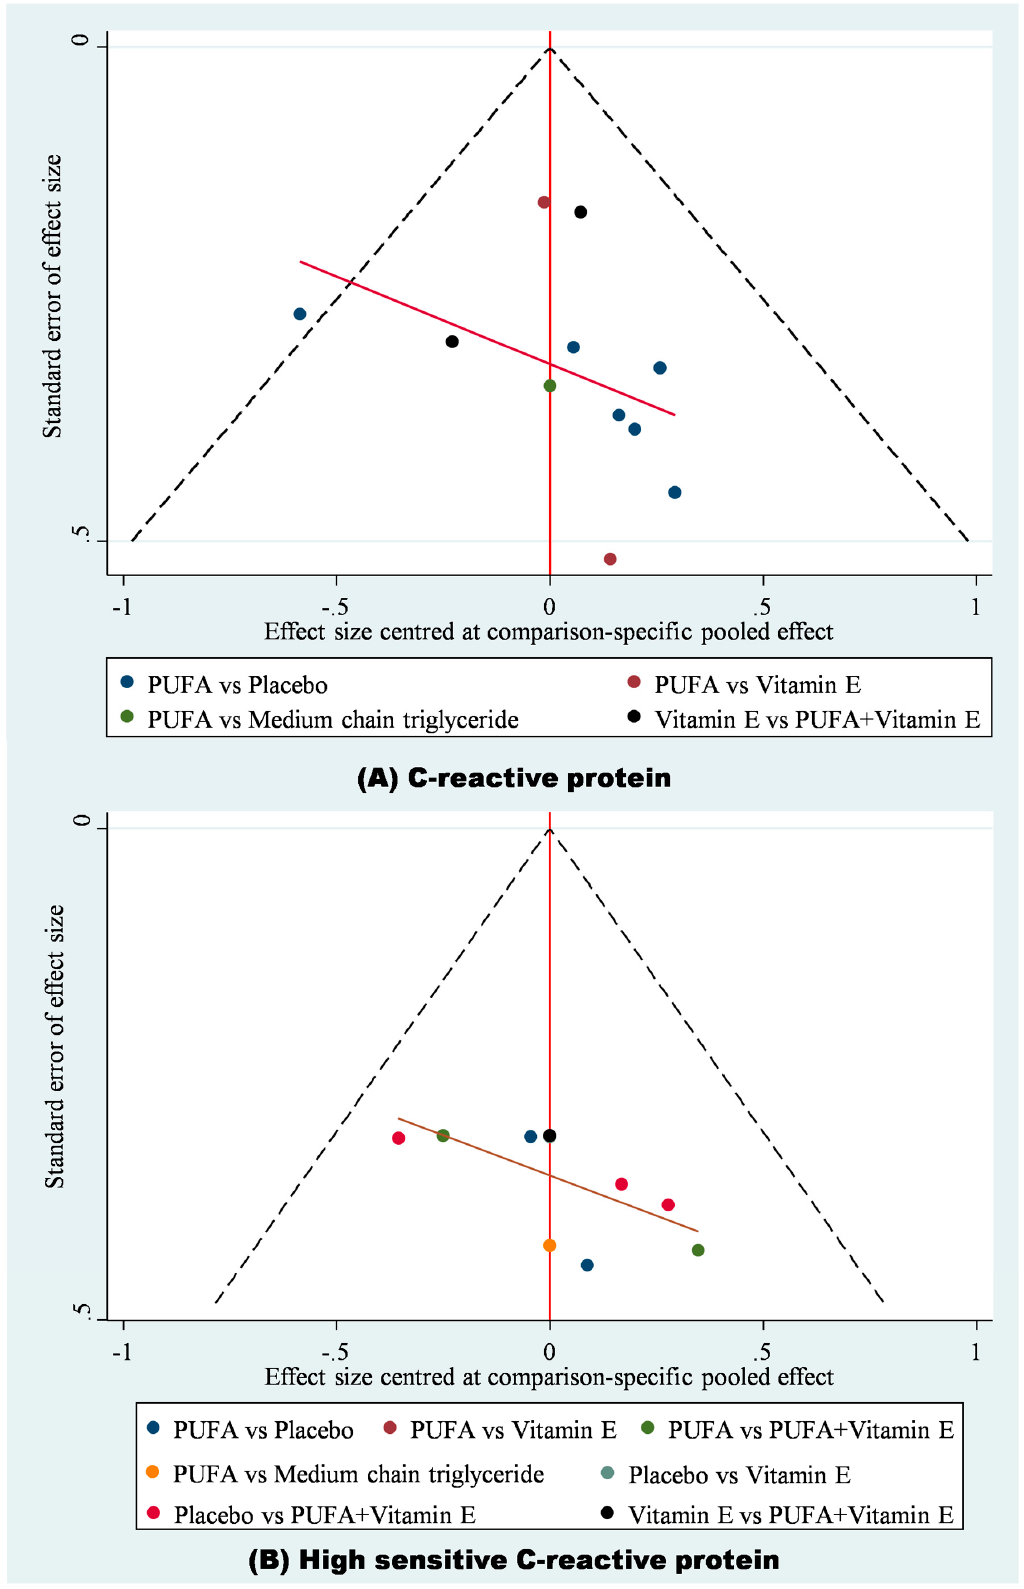
Figure 3. Funnel plots of ( A ) CRP and ( B ) high sensitivity CRP.